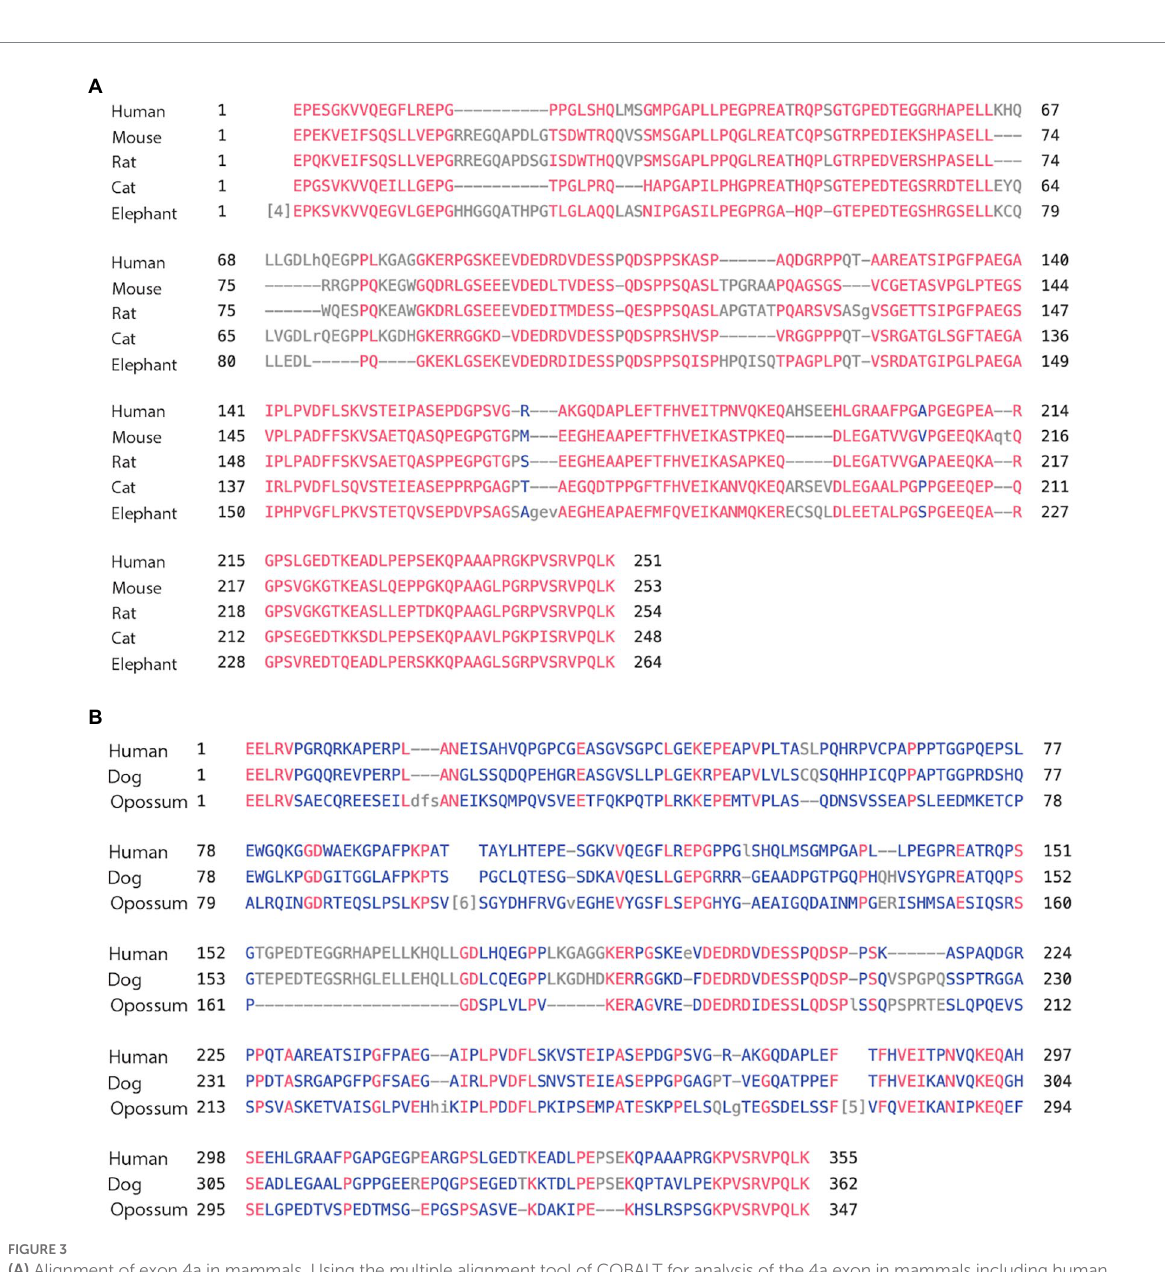
FIGURE 3 (A) Alignment of exon 4a in mammals. Using the multiple alignment tool of COBALT for analysis of the 4a exon in mammals including human, mouse, rat, cat, and elephant. (B) Alignment of exon 4a-L in mammals. Using the multiple alignment tool of COBALT for analysis of the 4a-L exon in mammals including human, dog, and